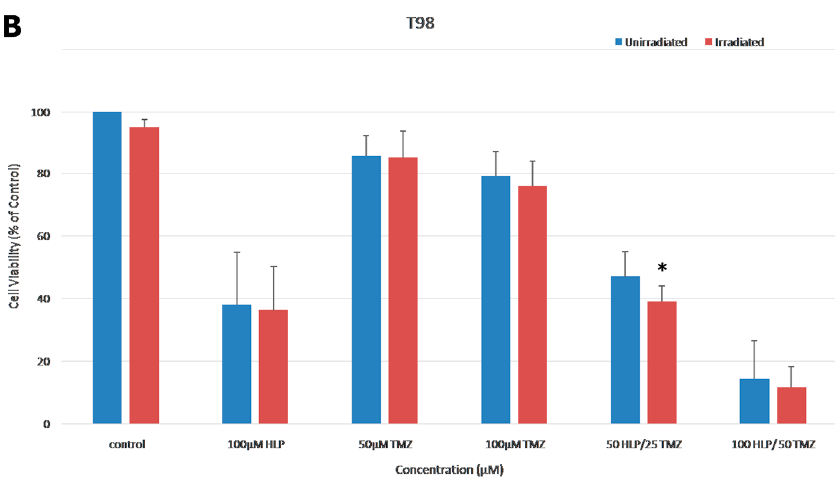
Figure 7. Combination treatment with haloperidol, TMZ and radiation. ( A , B ) 3-(4,5-Dimethylthiazol-2-yl)- 2,5-diphenyltetrazolium bromide (MTT) assay on U87 ( A ) and T98 ( B ) GBM cell lines treated with haloperidol (HLP), temozolomide (TMZ), radiotherapy and their combination. Cell viability was assessed with the MTT assay (% control). Approximately 5000 cells were seeded in 96-well plates and after 24 h exposed to various concentrations of HLP alone or in combination with TMZ with and without radiation (4 Gy) and incubated for another 72 h. At 72 h, MTT was added and the amount of MTT-formazan was determined by 570 nm absorbance as the wavelength reference. Significant differences ( p < 0.05) are marked with an asterisk.